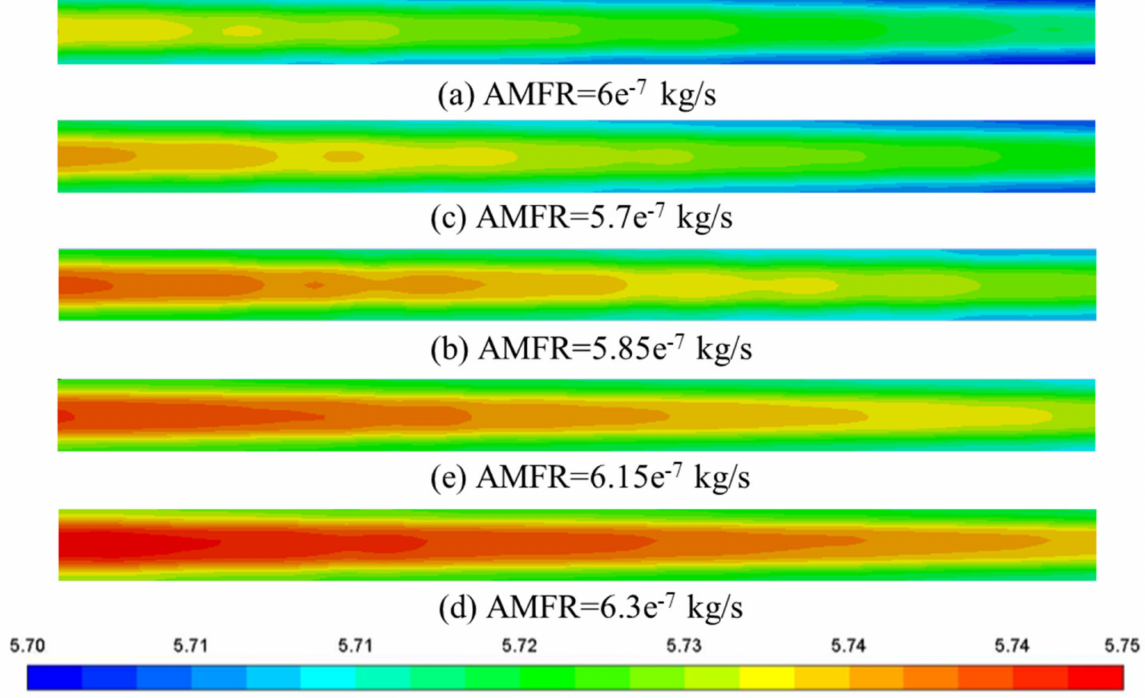
Figure 7. Water content distribution under the fluctuation of